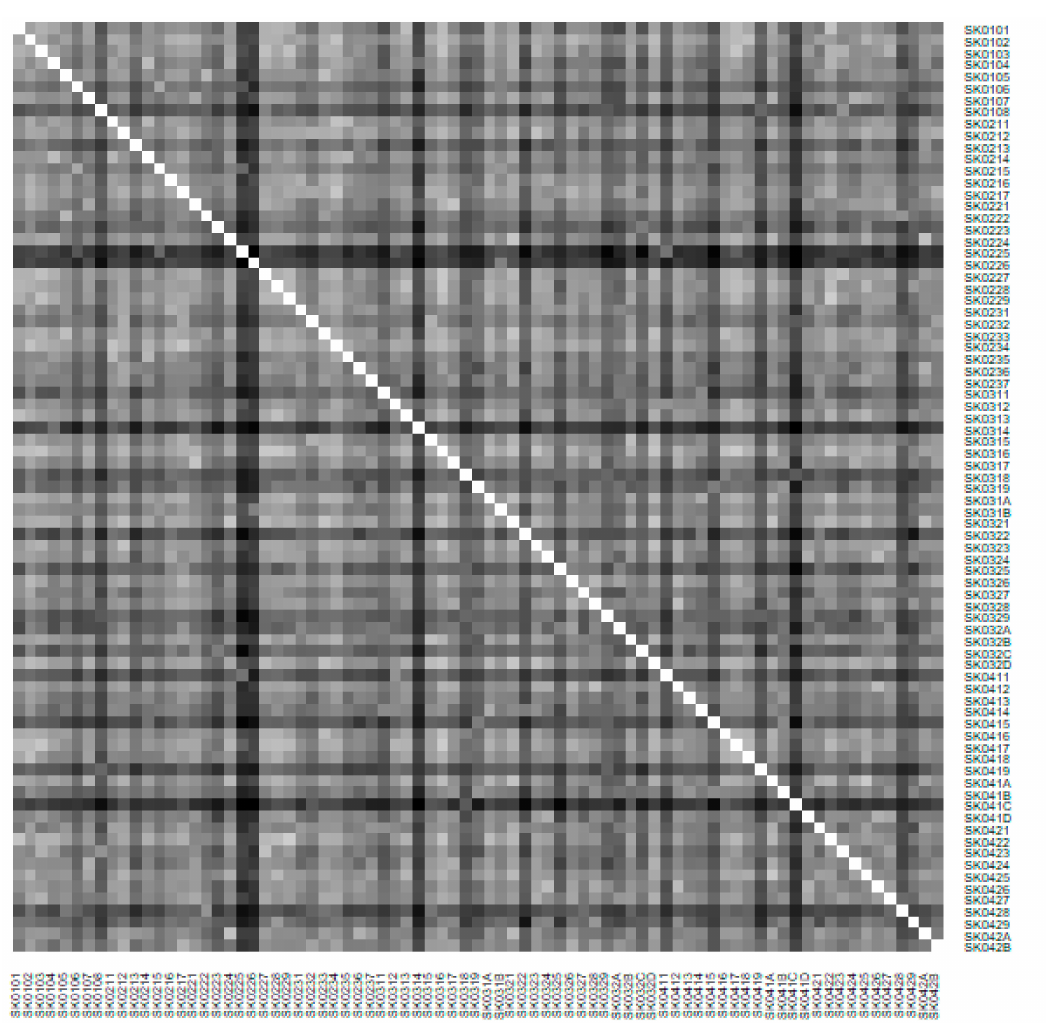
Figure 25. Preventable mortality heat map of the districts for the male sex in the year 2015. Source: own elaboration by the